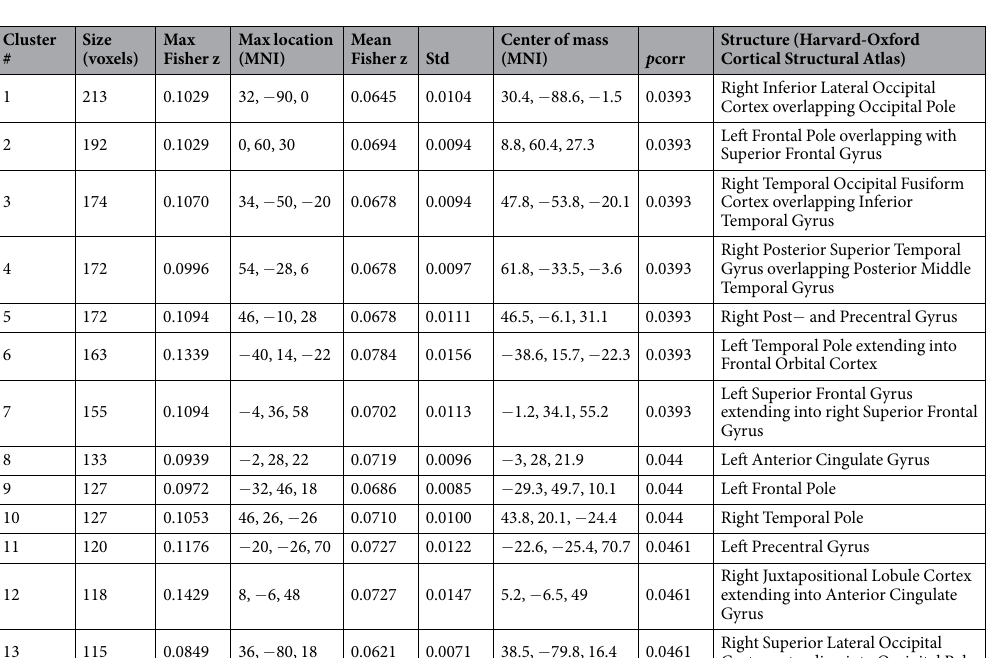
Right Superior Lateral Occipital Cortex extending into Occipital Pole